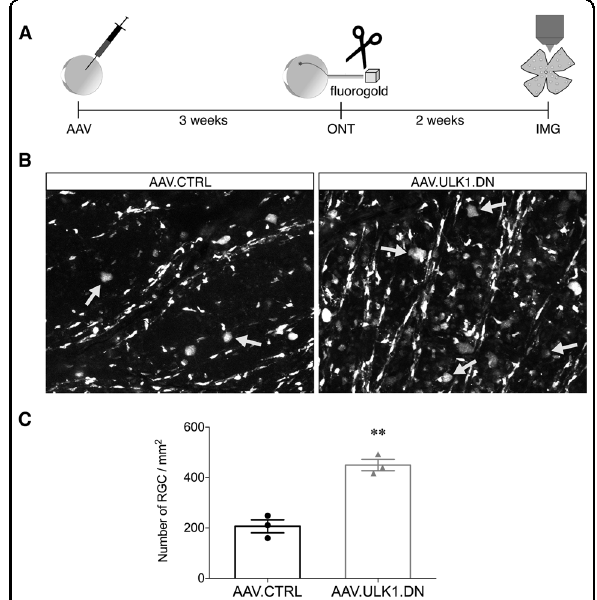
Fig. 4 AAV.ULK1.DN increases RGC survival after optic nerve transection. A Scheme of experimental setup. AAV vectors were intravitreally injected 3 weeks before optic nerve transection. Immediately after the lesion, RGCs were retrogradely labeled by application of FluoroGold onto the optic nerve stump. Survival of RGCs was evaluated 2 weeks post lesion on retina fl at-mounts. AAV: transduction with adeno-associated viral vectors; ONT: optic nerve transection; IMG: imaging. B Representative images of the inner retina showing FluoroGold-positive cells in retina fl at-mounts transduced with given AAV. Arrows indicate FluoroGold-positive RGCs, identi fi ed by morphological criteria. Scale bar: 50 μ m. C Quanti fi cation of the mean number of FluoroGold-positive RGCs in the inner retinal radii after transduction with AAV.CTRL ( n = 3 animals) or AAV.ULK1.DN ( n = 3 animals). Data are presented as single data points and means ± SEM. ** P < 0.01, according to two-tailed unpaired t